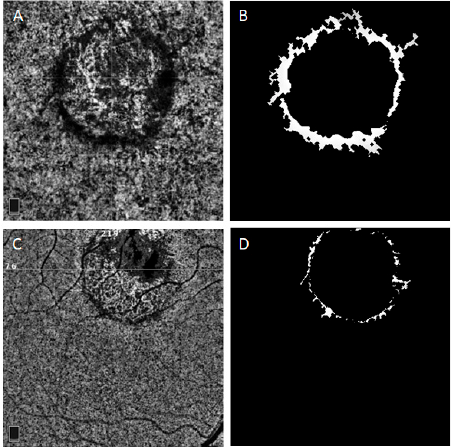
Figure 8. Result of SEG-DH. ( A , C ) original choroidal enface, ( B , D ) the predicted area by CNV-DH.